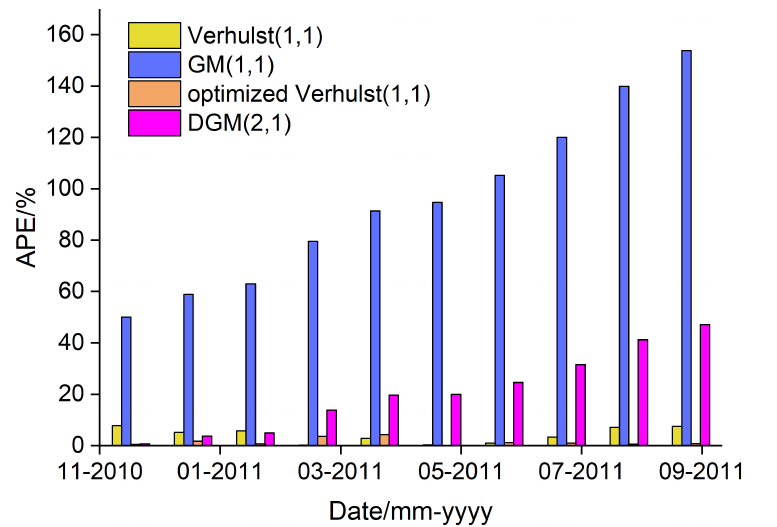
Figure 3. APE histogram between the original measured value and prediction values of four predic- tion models from Dec-2010 to Sep-2011 (next 10 testing sample data). Table 3. The comparison results between predicted and actual value by four models from Dec-2010 to Sep-2011 (next 10 testing sample